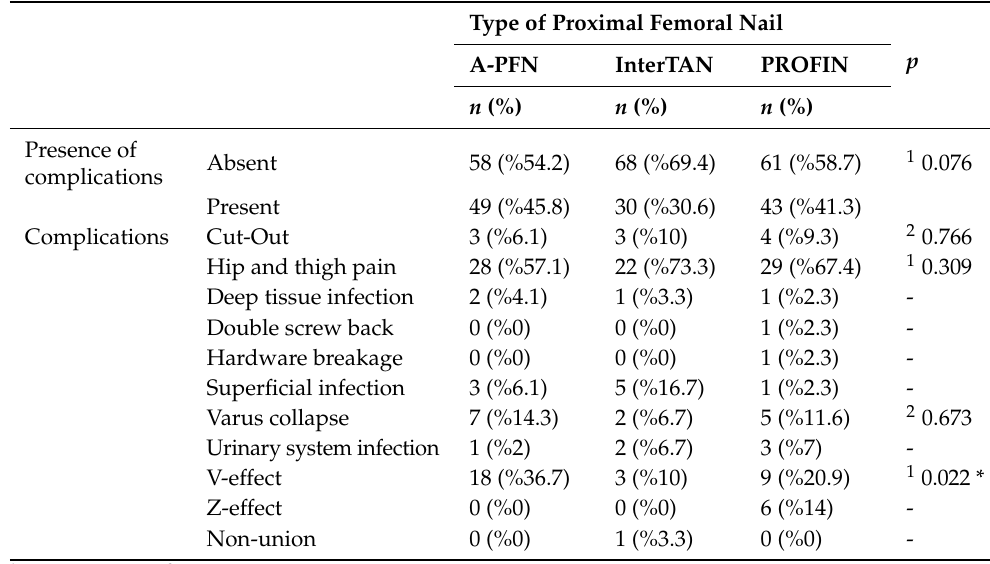
Table 6. Evaluation of complication occurrence among proximal femoral nail subgroups.